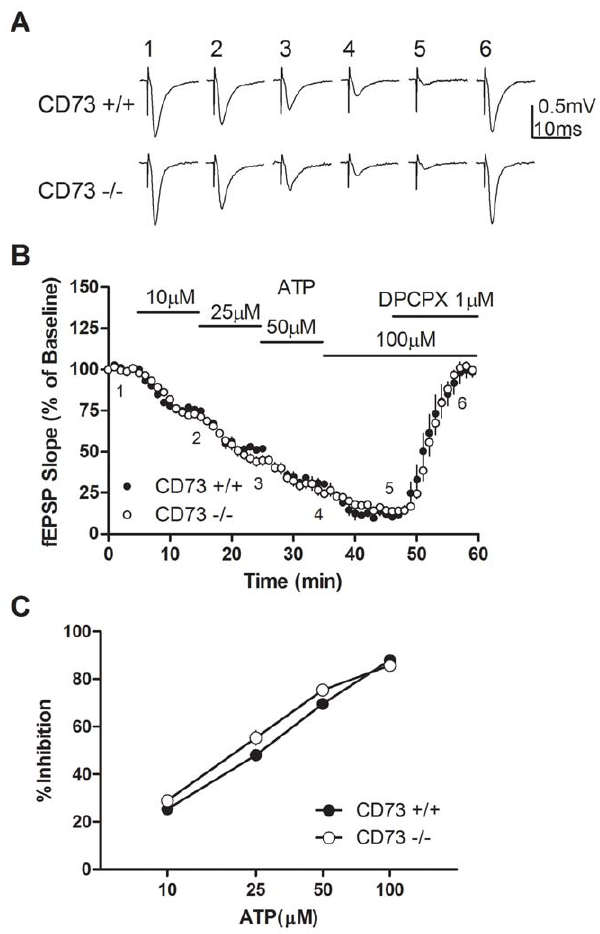
Figure 3. Inhibition by ATP of fEPSP recordings in hippocampal slices from CD73 + / + and CD73 2 / 2 mice. (a) Representative traces of fEPSPs; numbers 1–6 correspond to before and during superfusion of slices with ATP (10, 25, 50 or 100 m M) or ATP (100 m M) and DPCPX (1 m M) as indicated in (b). (b) The effect of ATP on fEPSP slope in hippocampal slices from CD73 + / + and CD73 2 / 2 mice. Horizontal lines represent the duration of superfusion with the indicated ATP concentrations. (c) Maximum inhibition of fEPSPs obtained with each concentration of ATP. n =4 CD73 + / + and 5 CD73 2 / 2 .